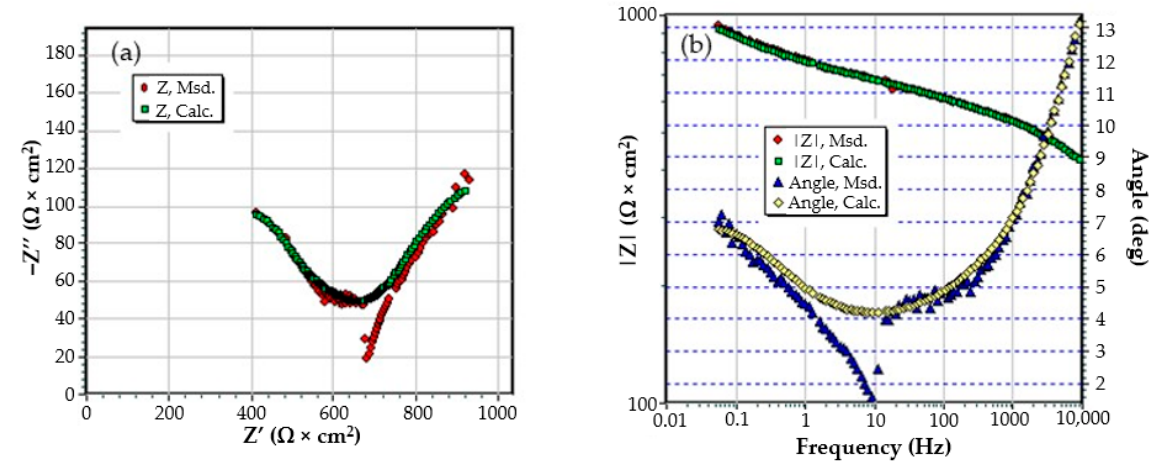
Figure A5. The Nyquist diagram ( a ) and Bode diagram ( b ) for PPS sample after 36 days of immersion in BSW.